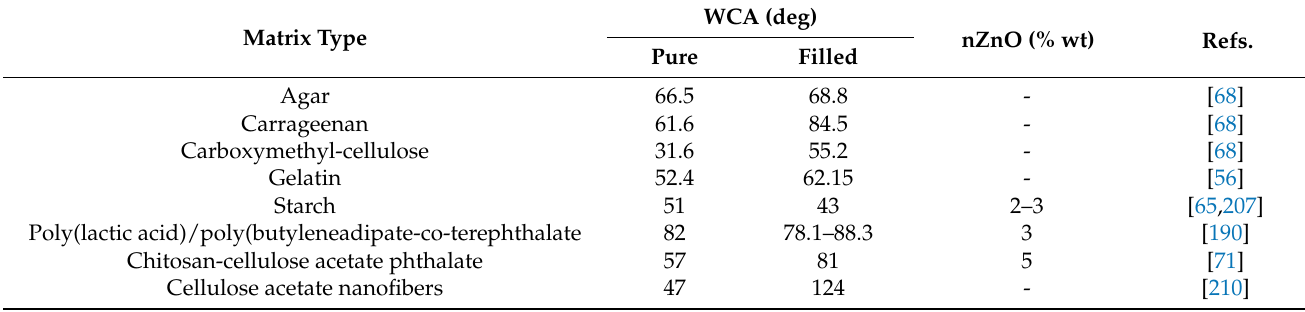
Table 3. Effect of nZnO’s presence on the WCA of different